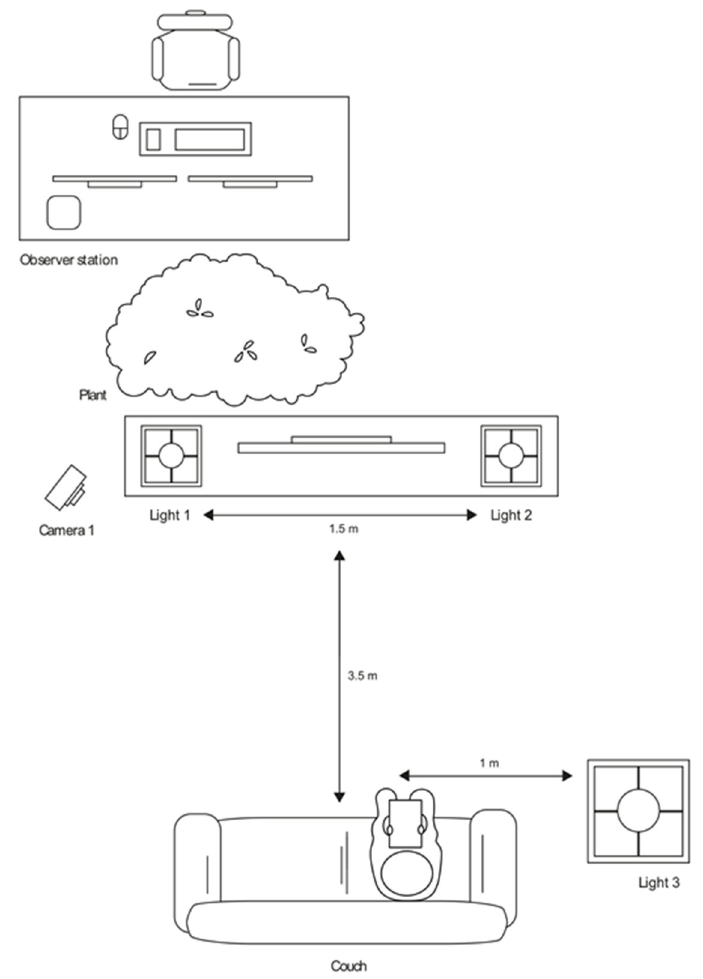
Figure 1. Experimental setup.